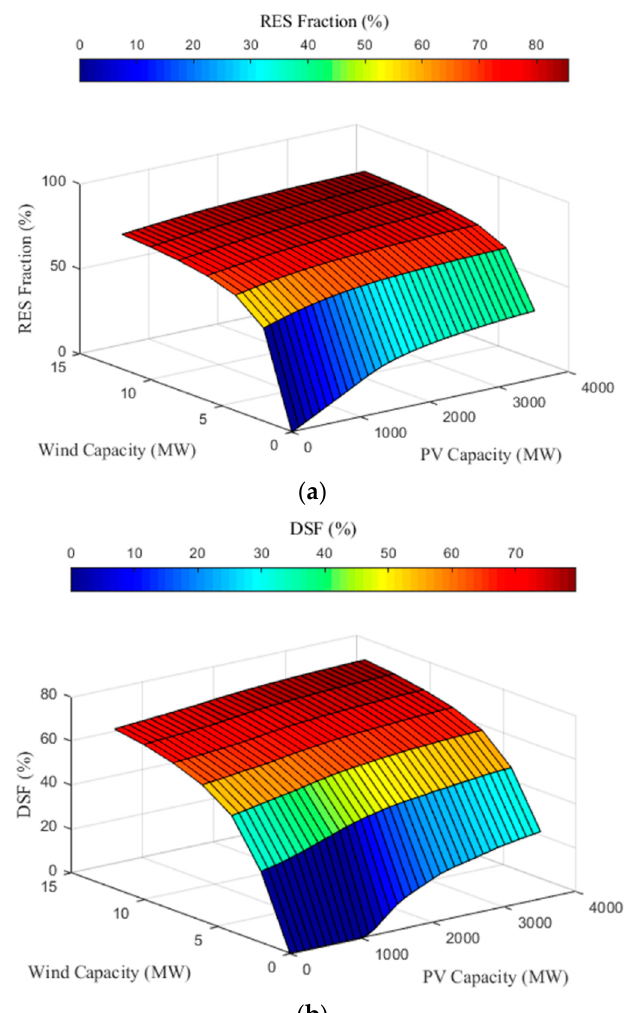
Figure 2. The technical parameters of different PV/wind hybrid system sizes in Gwanda: ( a ) renewable energy systems (RES) fraction and ( b ) demand supply fraction.